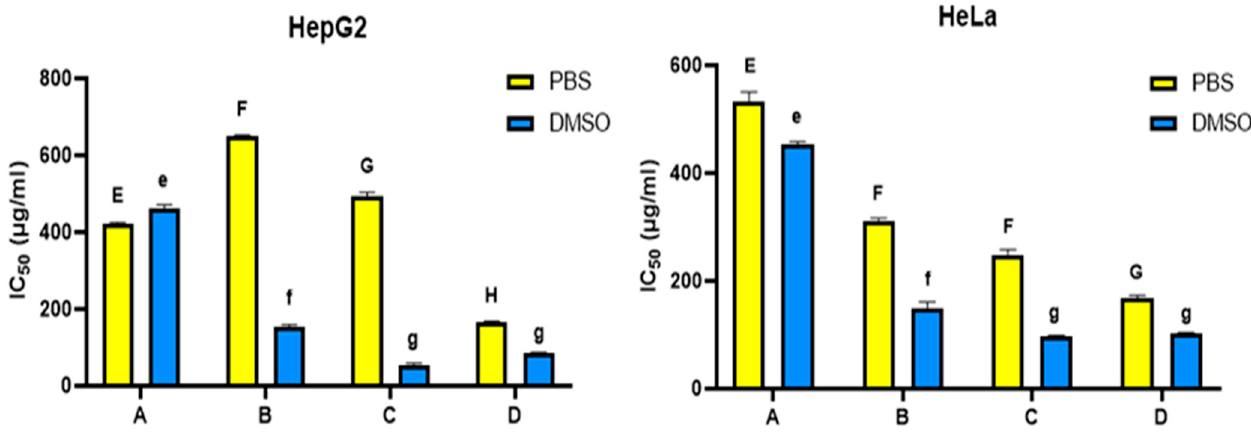
Figure 4. IC 50 in microgram/mL of hemolymph extracts of honey bees dissolved in PBS or DMSO against Hepg2 and HeLa cell lines, where ( A ): bees from Port Said, ( B ): bees from Ismailia governorate, ( C ): bees from Suez governorate, ( D ): bees from Saint Catherine. Bars and error bars represent the mean values ± SE obtained from triplicate measurements. Different letters above bars indicate significant differences (Tukey’s test, p < 0.05): uppercase letters show comparisons across PBS dissolved samples; lowercase letters show comparisons across DMSO dissolved samples.